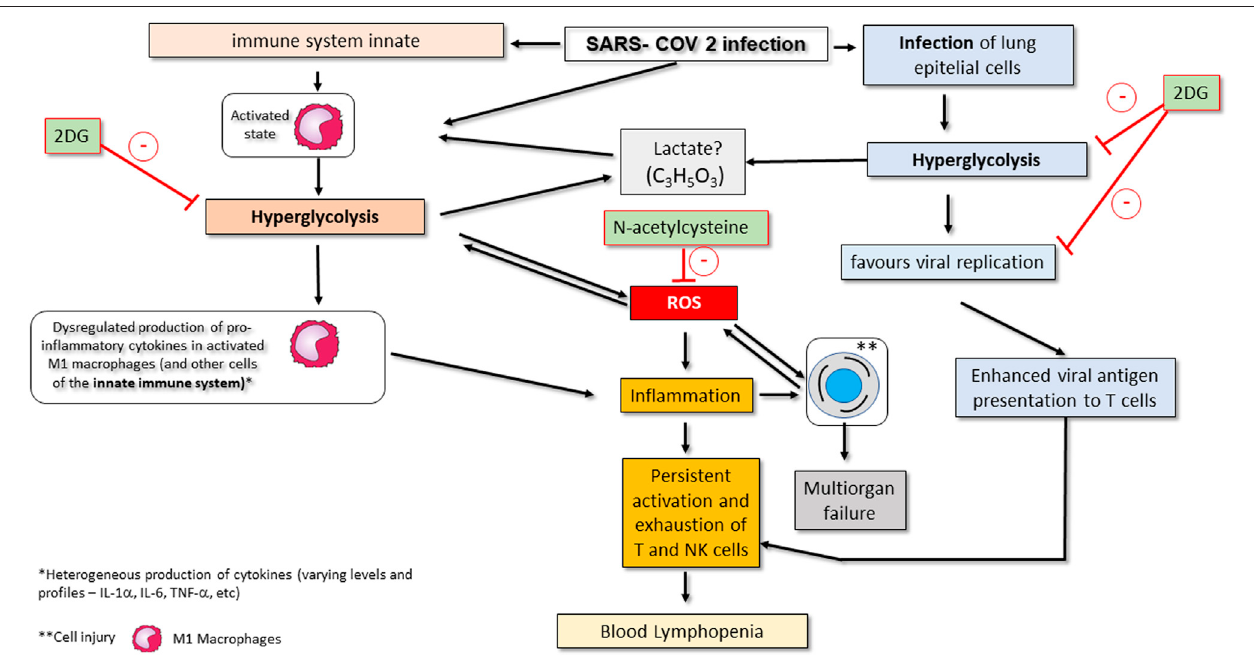
FIGURE 2 | Conceptual model of SARS-CoV-2-associated changes in the glycolytic pathway and its consequences on COVID-19 in critically ill patients. Viral infection activates the innate immune system, namely M1 macrophages. Activation of macrophages promotes metabolic changes for their effective action, including an increase inconsumptionofglycolysis(hyperglycolysis)and achangeinthestrategy forATPsynthesis ( metabolicreprogramming ).Thesechangesfavour theproduction ofROSandworsenin fl ammation.Hyperglycolysismayalsopromoteanincreaseinserumlactate.SARS-CoV-2infectionalsoaffectsepitheliallungcellsbymaking them increase their glucose consumption, which makes viral replication viable. Infected epithelial cells also show enhanced presentation of viral antigens to T lymphocytes (particularly CD8 + T cells), and NK cells are also affected, with both cell types becoming more chronically activated. These events promote exhaustion and subsequent apoptosis of T and NK cells, thereby contributing to peripheral lymphopenia. Drugs that may eventually be used as complementary treatment of severe COVID-19 infection by inhibition infection-associated hyperglycolysis include 2-deoxy- D -glucose (2DG), N-acetylcysteine or GLUT1 inhibitors. Administration of 2DG inhibits hyperglycolysis in innate immune system cells such as macrophages; on the other hand, the administration of N -acetylcysteine inhibits the increase in ROS production by activating glutathione (see therapeutic strategies section). The action of GLUT1 inhibitors is not shown but involves blocking glucose uptake in activated and infected immune system and epithelial